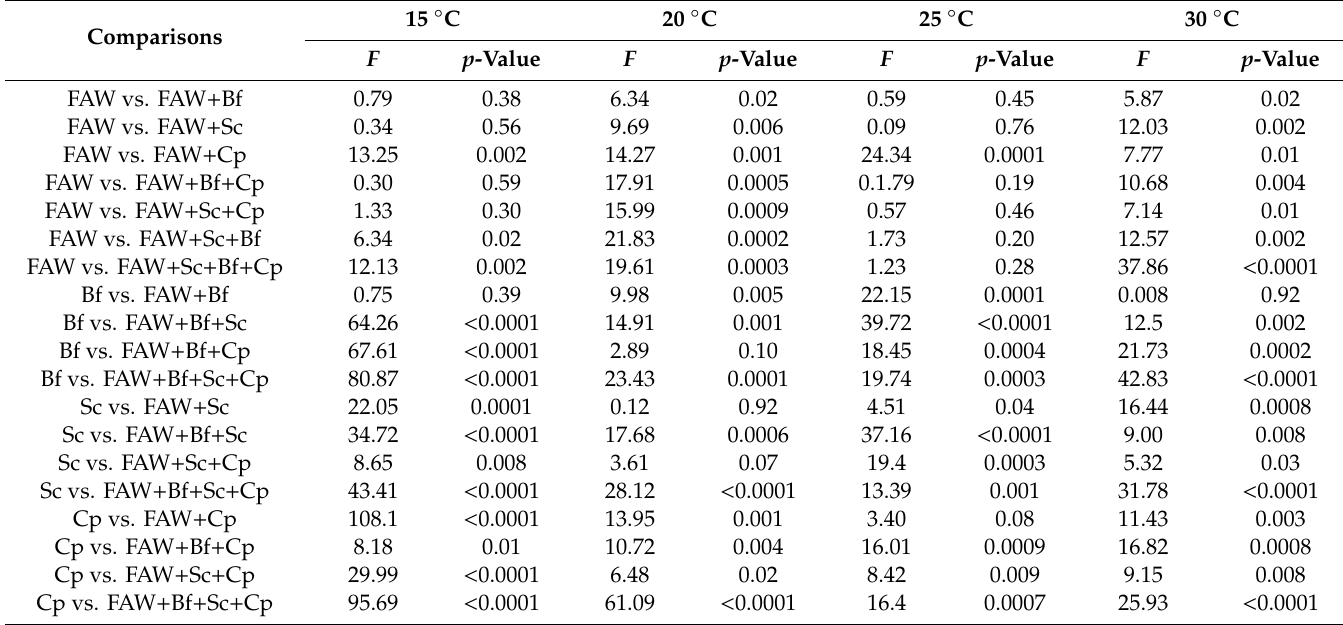
Table 6. Results of ANOVA comparing the relative growth rates between single-species and multi-species combinations under di ff erent constant temperatures.